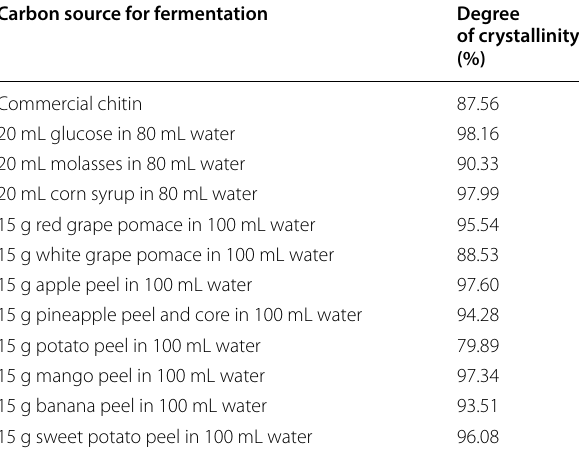
Table 5 degree of crystallinity of chitin extracted after fermentation on various carbon